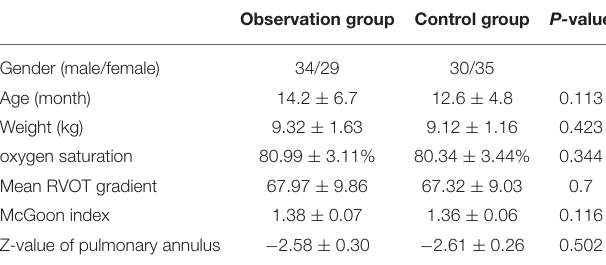
TABLE 1 | Preoperative data from the two groups. Observation group Control group P-